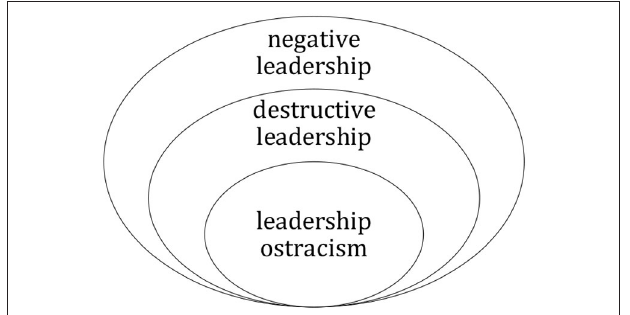
FIGURE 1 | Venn diagram of negative leadership, destructive leadership, and leadership